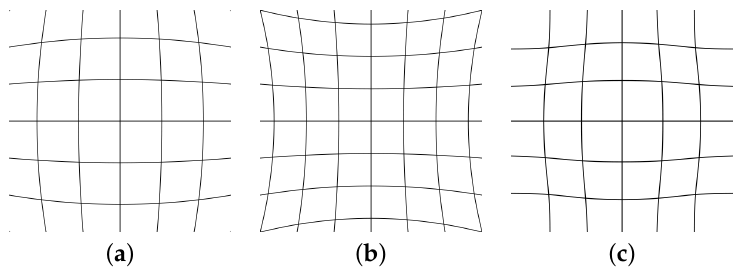
Figure 5. Different models of optical distortions. ( a ) Barrel [51]; ( b ) Pincushion [52]; ( c ) Moustache [53].